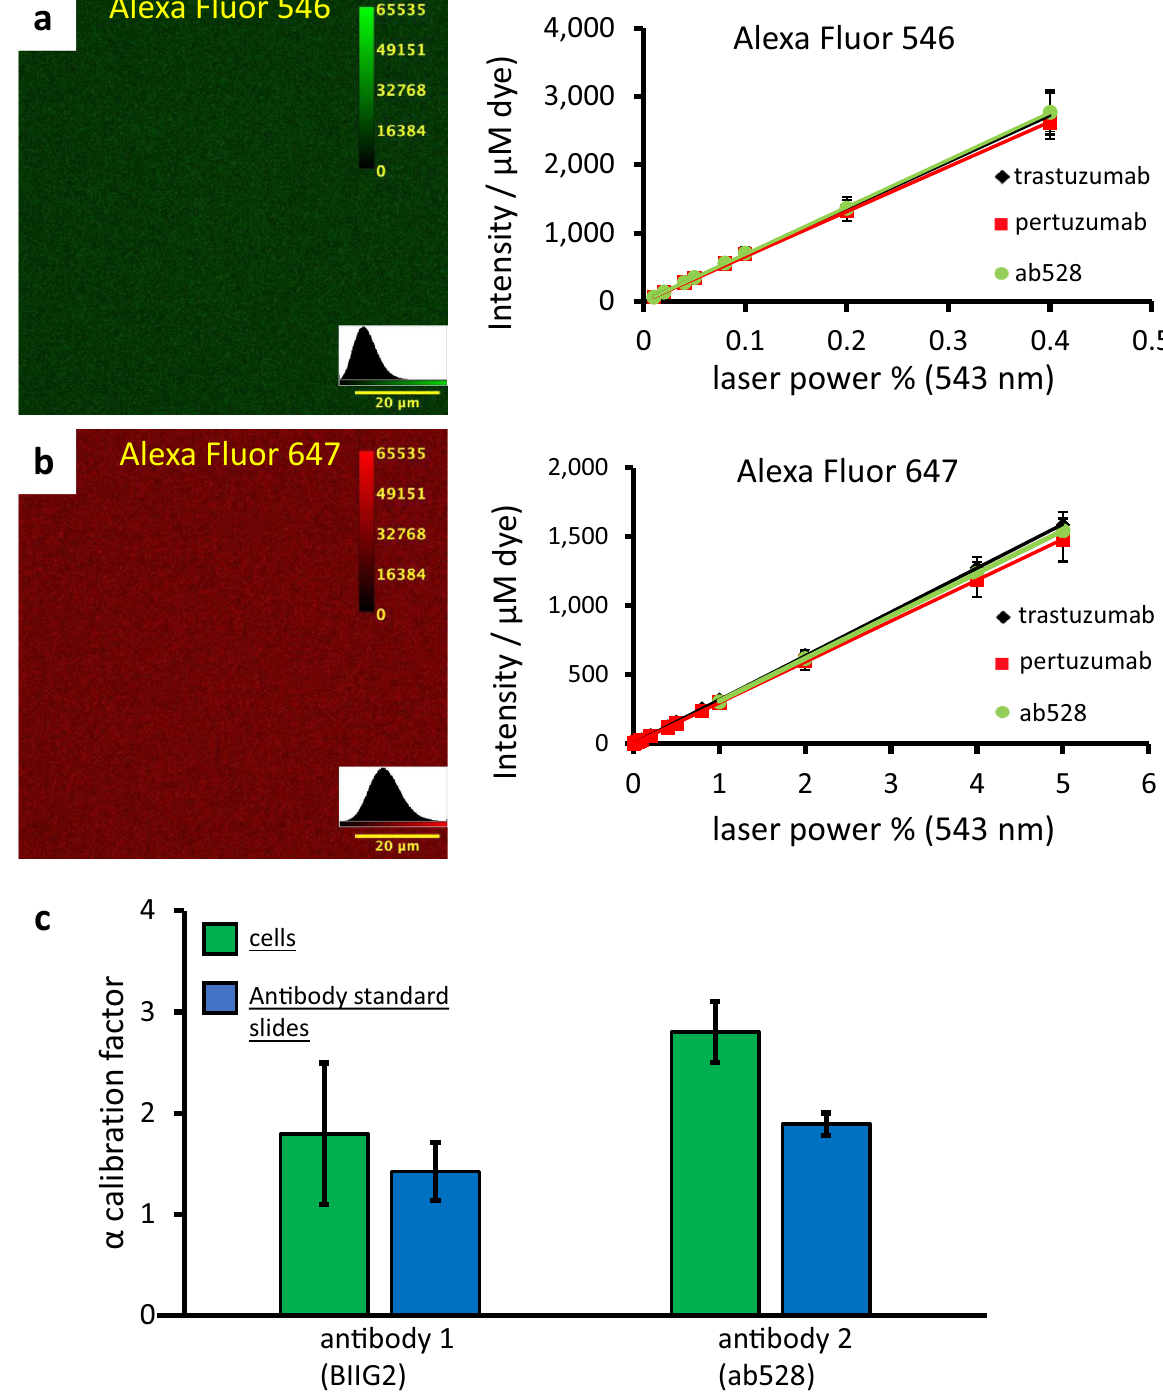
Figure 2. Standard slides for determining the instrument calibration (α) and spectral spillover (S) factors. ( a , c ) Images of Alexa Fluor 546 and 647 conjugated trastuzumab film with pixelwise intensity distributions as insets. ( b , d ) Average intensities of 3 different antibodies conjugated to Alexa Fluor 546 or Alexa Fluor 647, plotted against 543 nm excitation laser powers, normalized to dye concentration. Error bars represent ± SD of n = 5 images ( c ) α calibration factor determined on A172 cells and on standard slides using two different antibodies. Error bars are ± SD from n = 6